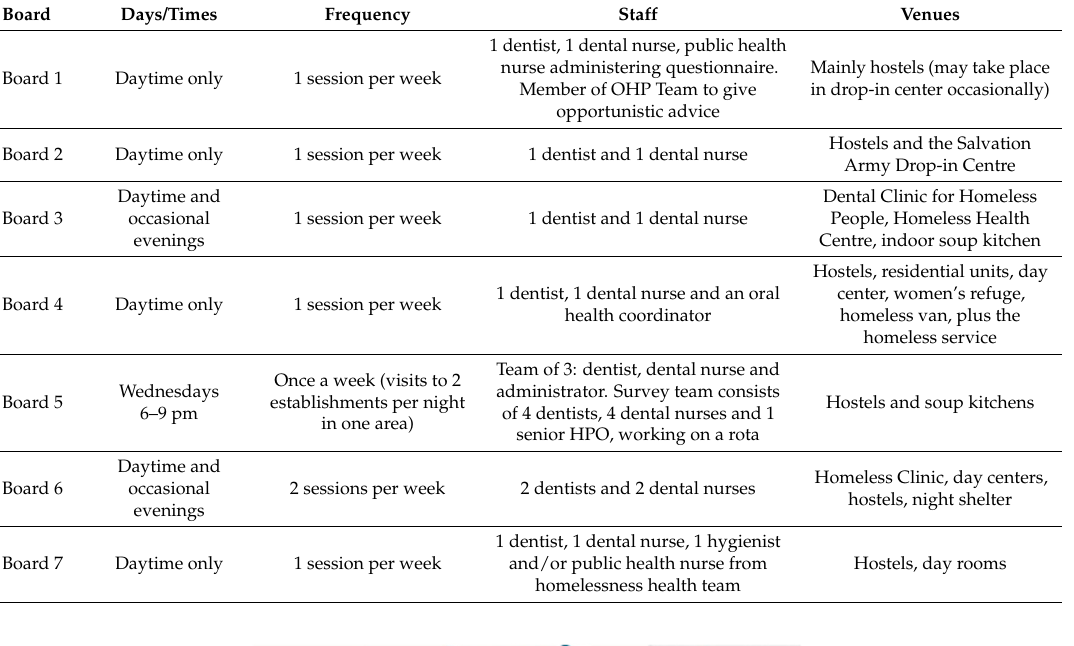
Table 1. Details of data collection by participating National Health Services (NHS) Boards.